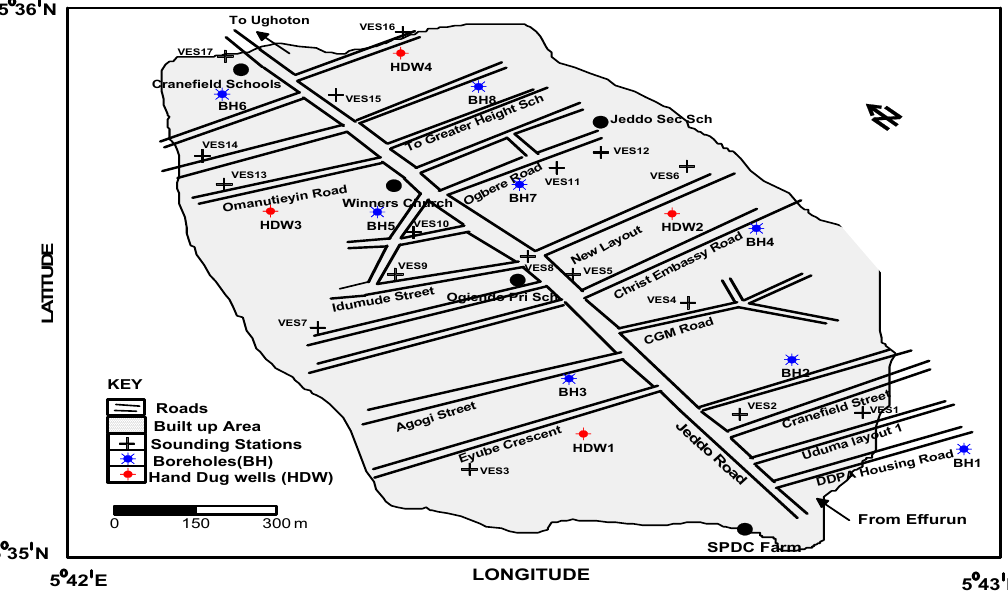
Figure 2. Map of the study area showing the positions of boreholes and vertical electrical soundings.